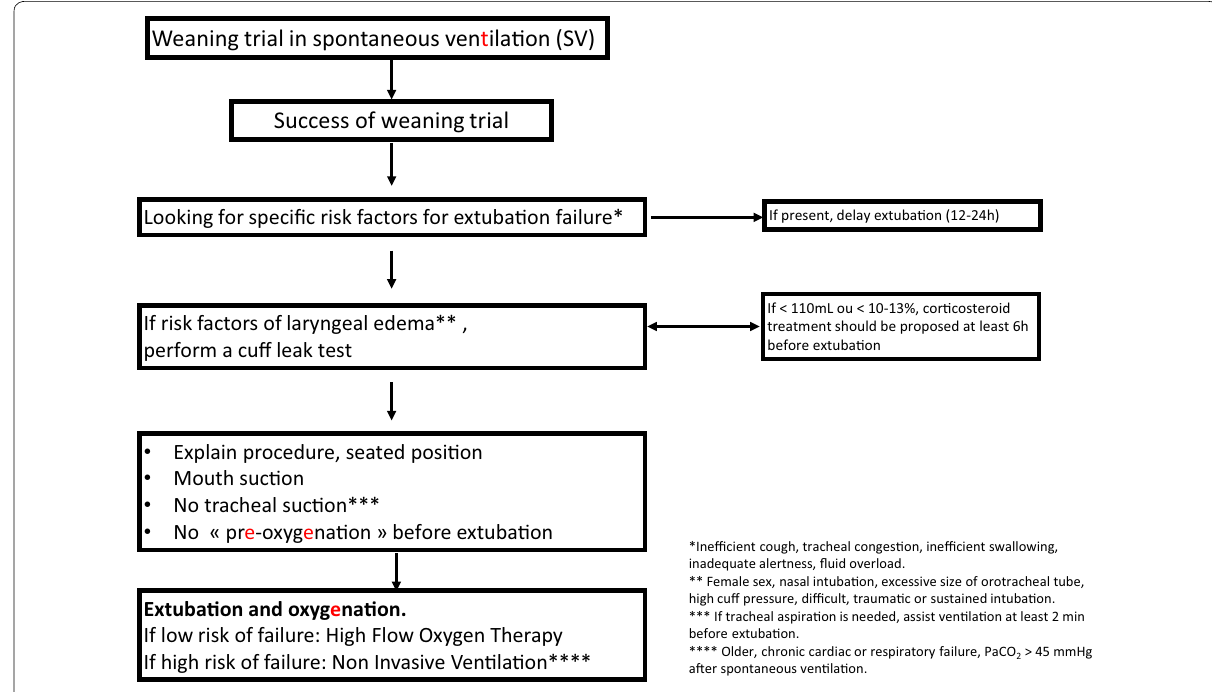
Fig. 2 Algorithm for